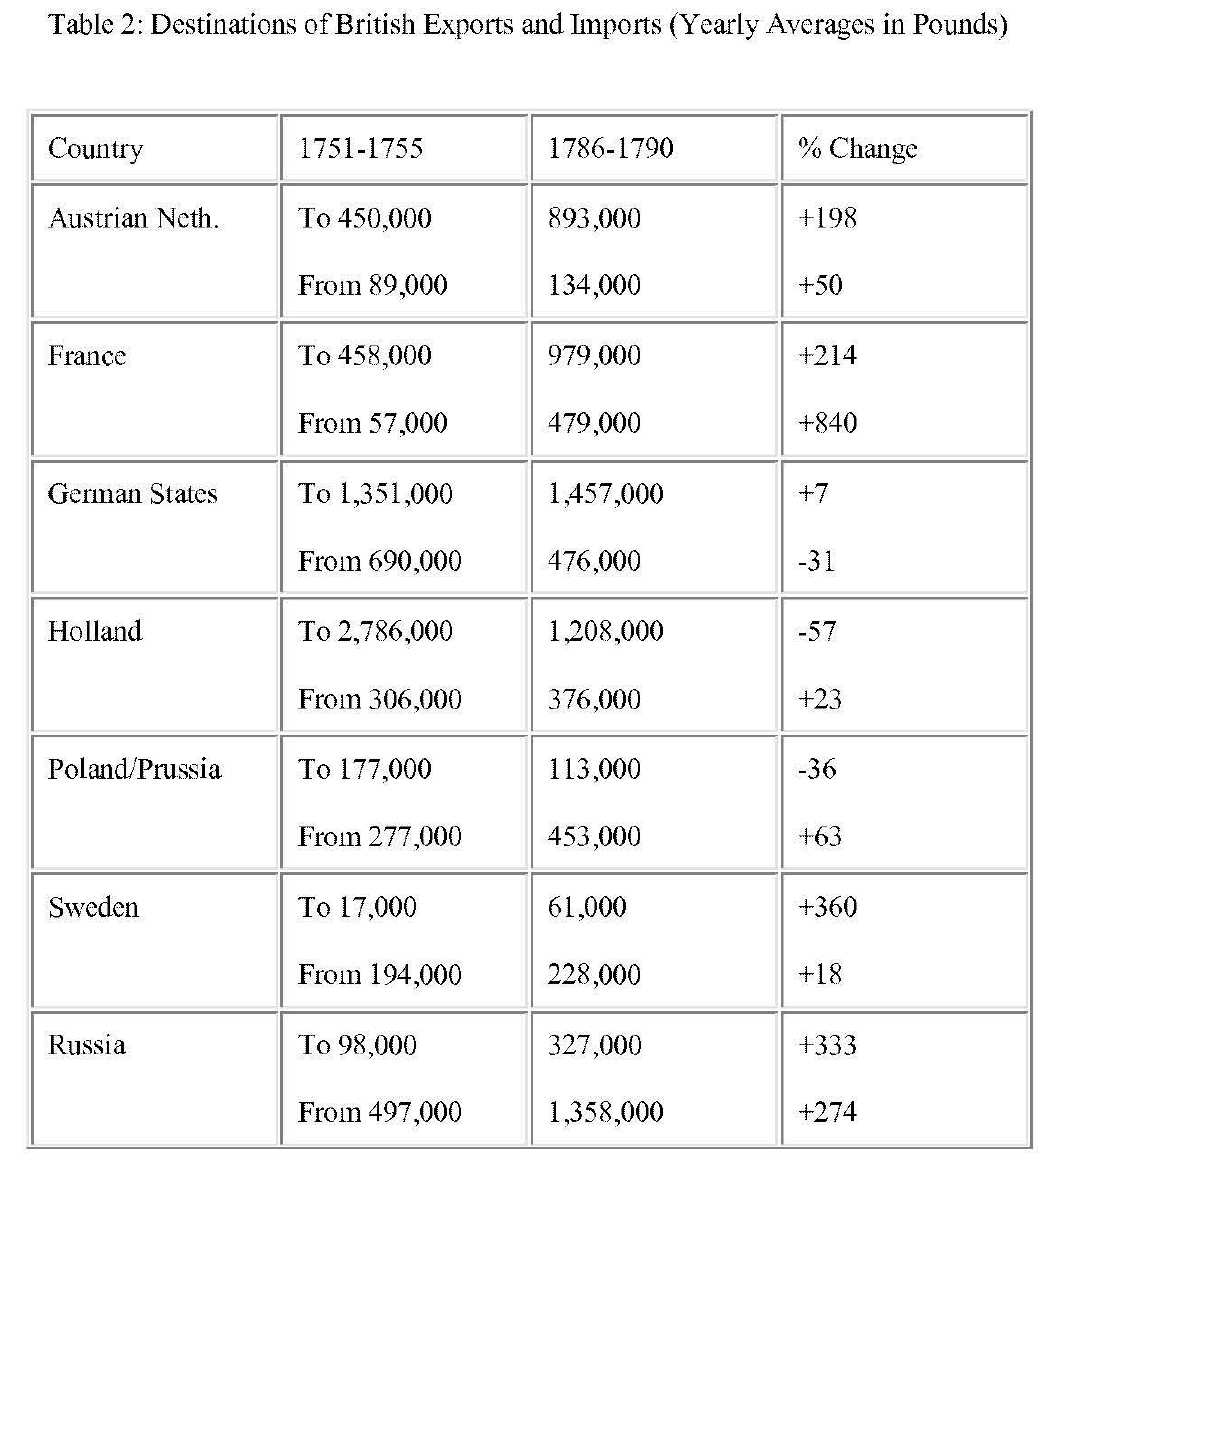
Table 2: Destinations of British Exports and Imports (Yearly Averages in Pounds)